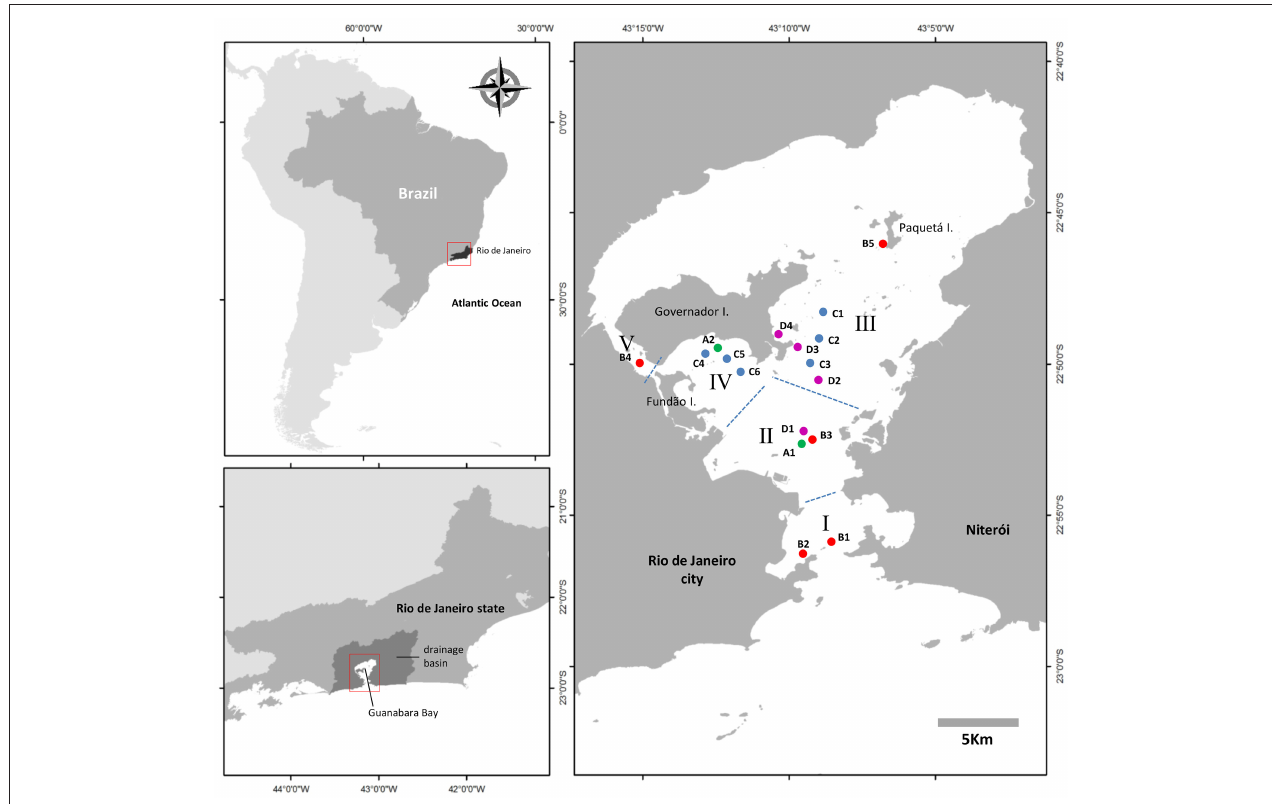
FIGURE 1 | Map of Guanabara Bay showing the locations sampled in this study. Four sampling series (series A: green dots; series B: red dots; series C: blue dots; series D: magenta dots) were conducted from February, 2014 to January, 2018 to monitor C. subsalsa cell concentration in surface waters of the bay. Samples collected in series B were also analyzed for physical and chemical water parameters. Roman numbers represent zones within an eutrophication gradient from I (less impacted) to V (more impacted). See text for details on each sampling